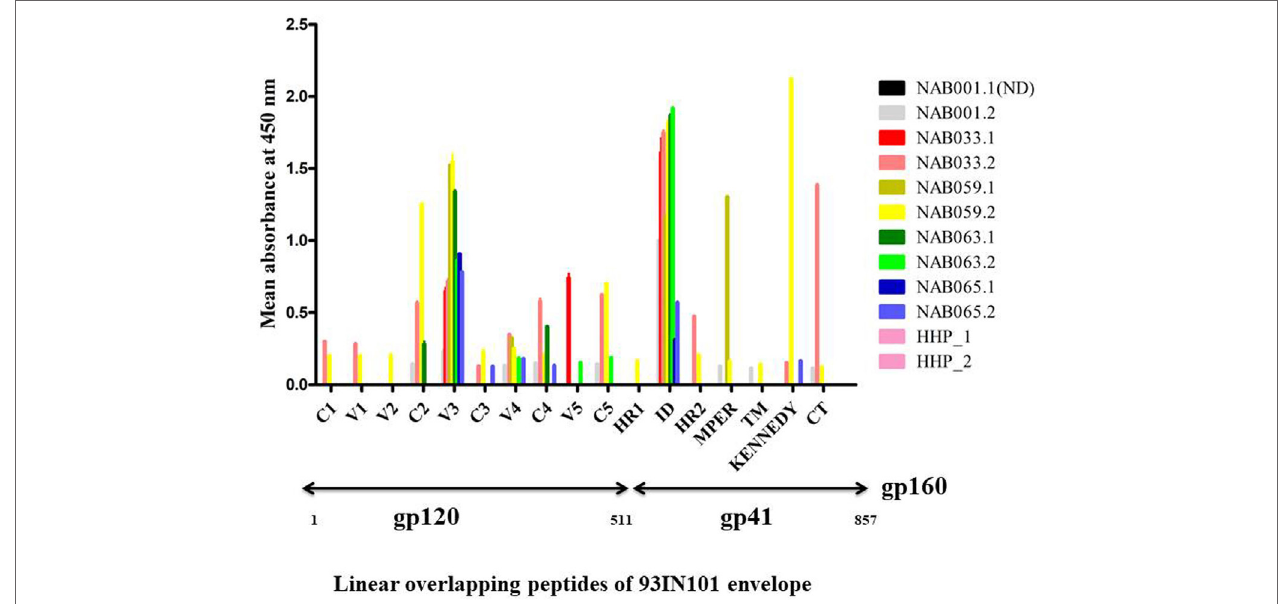
FigUre 3 | Antibody binding to linear overlapping peptides of 93IN101 Env gp160. ELISA was performed with a total of 192 peptides, 15 amino acids long with 11 amino acids overlap, covering the entire 93IN101 envelope (gp160) protein. Plasma samples from BCN samples ( n = 5) were tested at a dilution of 1:50 for determining binding reactivity. Healthy Human Plasma pool (HHP) was used as the negative control. This experiment was performed in duplicate on two independent occasions. Mean absorbance of HHP was 0.054; twofold of HHP absorbance (0.162) was considered as positive reactivity. Normalized absorbance values are used for the graphical representation. ND indicates not done.